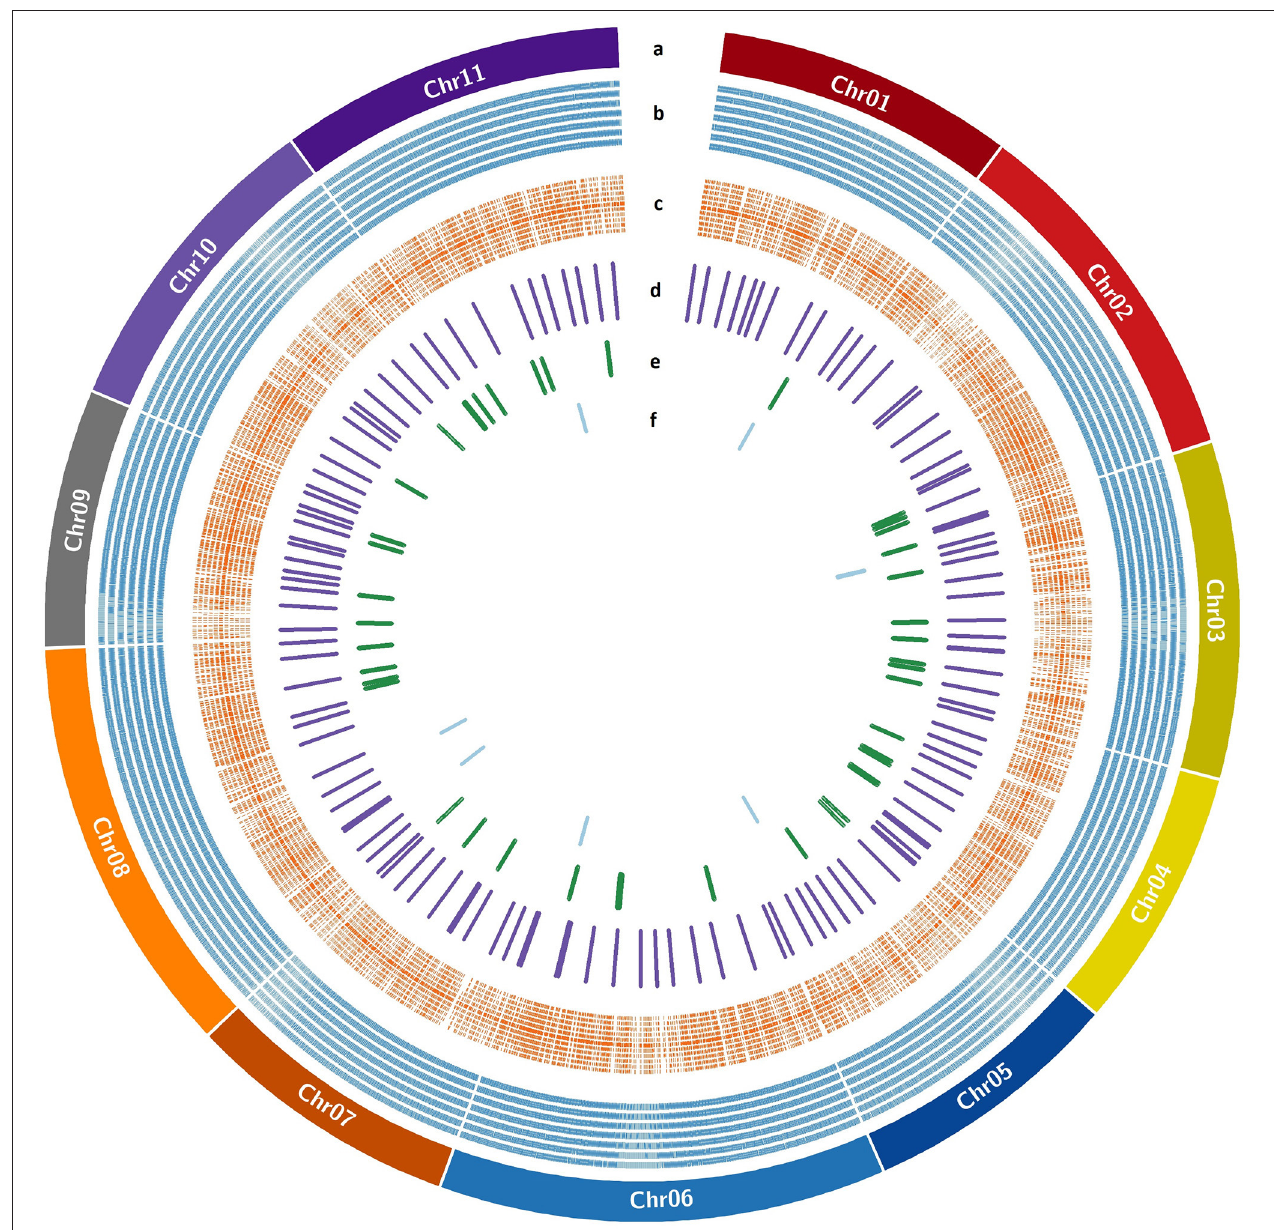
FIGURE 6 | EST-SSR/InDel/SNP markers distribution over guava pseudochromosomes. (a) Guava pseudochromosomes, (b) SSR markers designed with Primer3design, (c) KASP markers designed with Polymarker, (d) validated KASP markers, (e) validated InDel markers, and (f) validated SSR markers.